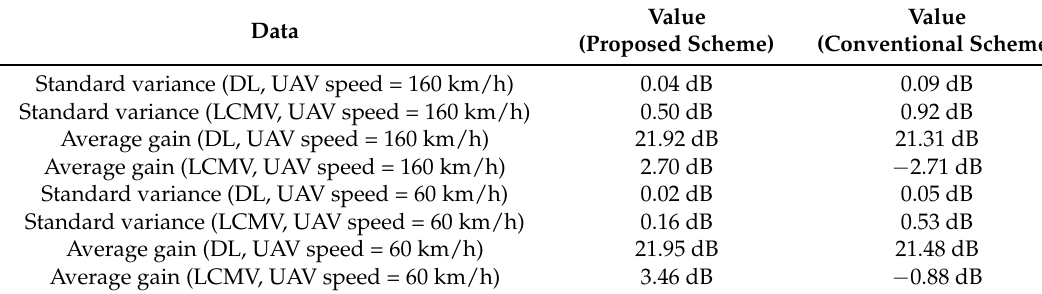
Figure 6. SINR performance of the proposed and the conventional beamforming schemes. ( a ) The UAV speed is 160 km/h. ( b ) The UAV speed is 60 km/h. Table 3. Statistics of the SINR